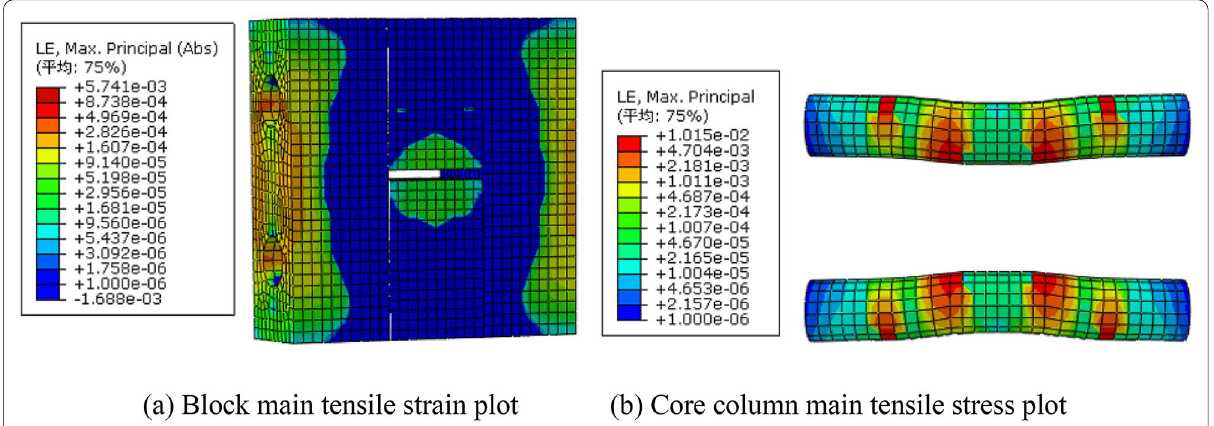
Fig. 15 Strain plot of SK1 specimen under peak